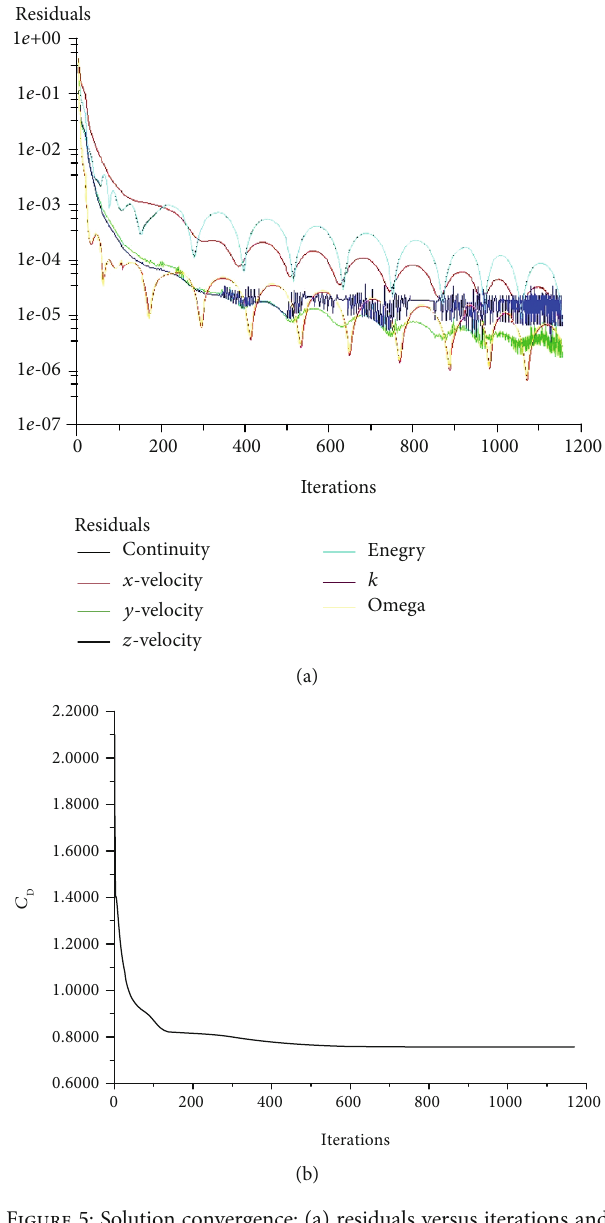
Figure 5: Solution convergence: (a) residuals versus iterations and (b) C D value versus iterations.